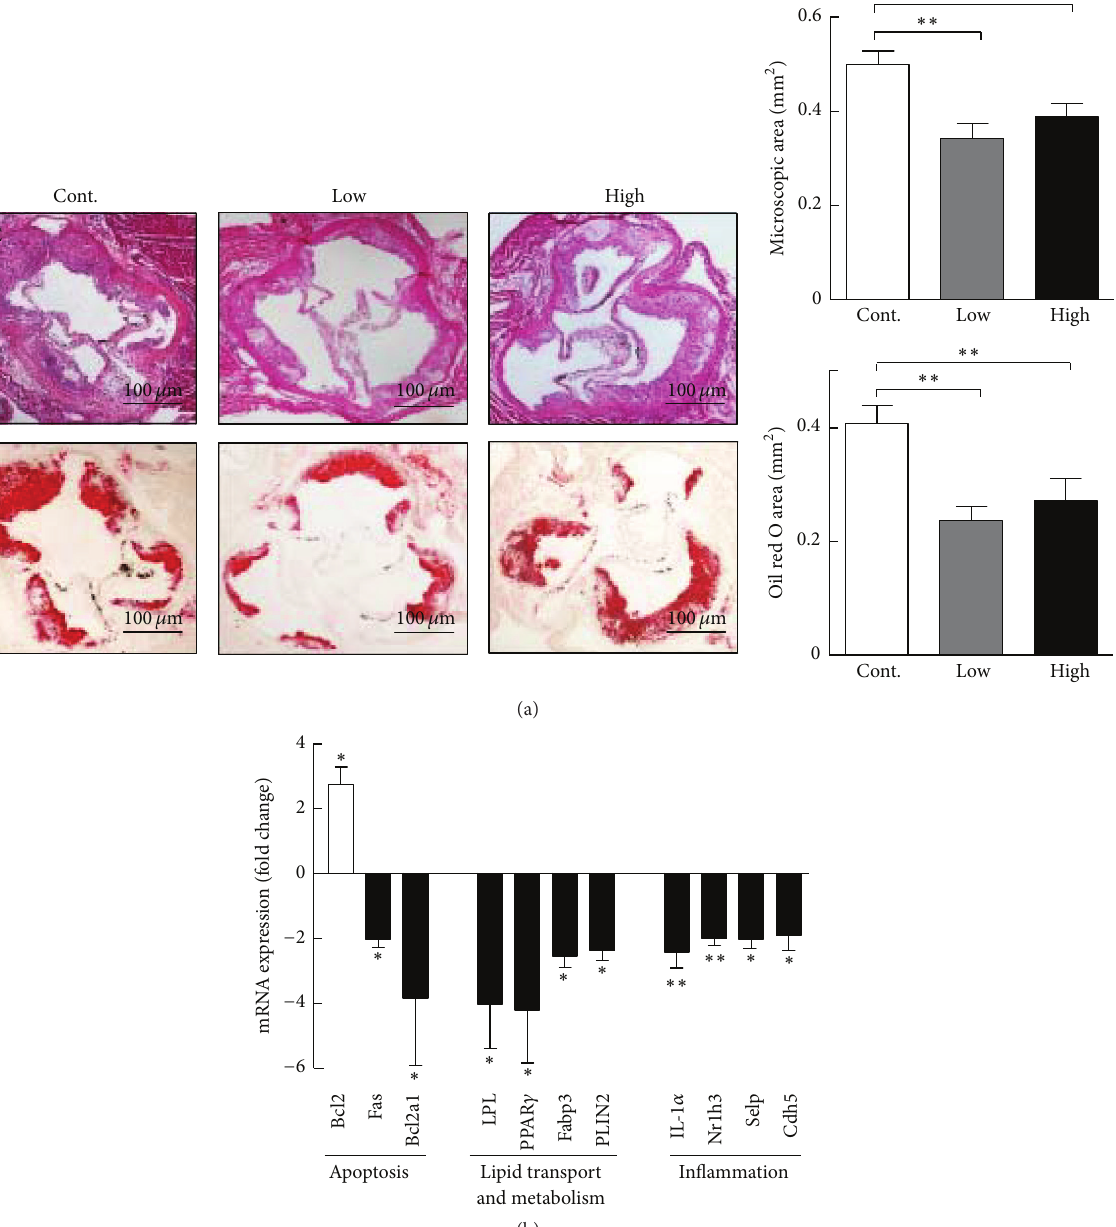
Figure 3: Representative micrographs of atherosclerotic lesions of the aortic root and gene expression changes in the aortas. (a) Aortic root sections are stained with hematoxylin-eosin (H&E) and oil red O (ORO). Quantitative analysis of aortic root lesion areas is shown in the right. 𝑛 = 8 for each group. (b) Gene expression changes in the aortas of the high cocoa powder group relative to the control group. 𝑛 = 3 for each group (pooled samples). Bcl2: B-cell leukemia/lymphoma 2; Fas: tumor necrosis factor receptor superfamily, member 6; Bcl2a1: Bcl2-related protein a1; LPL: lipoprotein lipase; PPAR 𝛾 : peroxisome proliferator-activated receptor gamma; Fabp3: fatty acid binding protein 3; PLIN2: perilipin 2; IL-1 𝛼 : interleukin-1 alpha; Nr1h3: nuclear receptor subfamily 1, group H, member 3; Selp: selectin P; Cdh5: cadherin 5. Data are expressed as the mean ± SEM. ∗ 𝑃 < 0.05 , ∗∗ 𝑃 < 0.01 versus control.